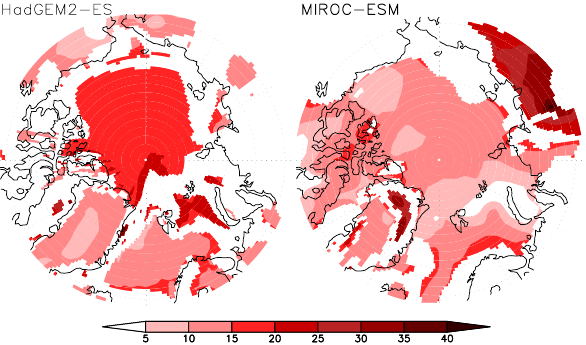
Fig. 15. Change in the top of the atmosphere absorbed solar ra- diation (W m − 2 ) from MH to PI, for (a) HadGEM2-ES and (b) MIROC-ESM. Only changes statistically significant at a 95% con- fidence level are shown. The increase in mid-Holocene shortwave absorption is stronger in HadGEM2-ES than